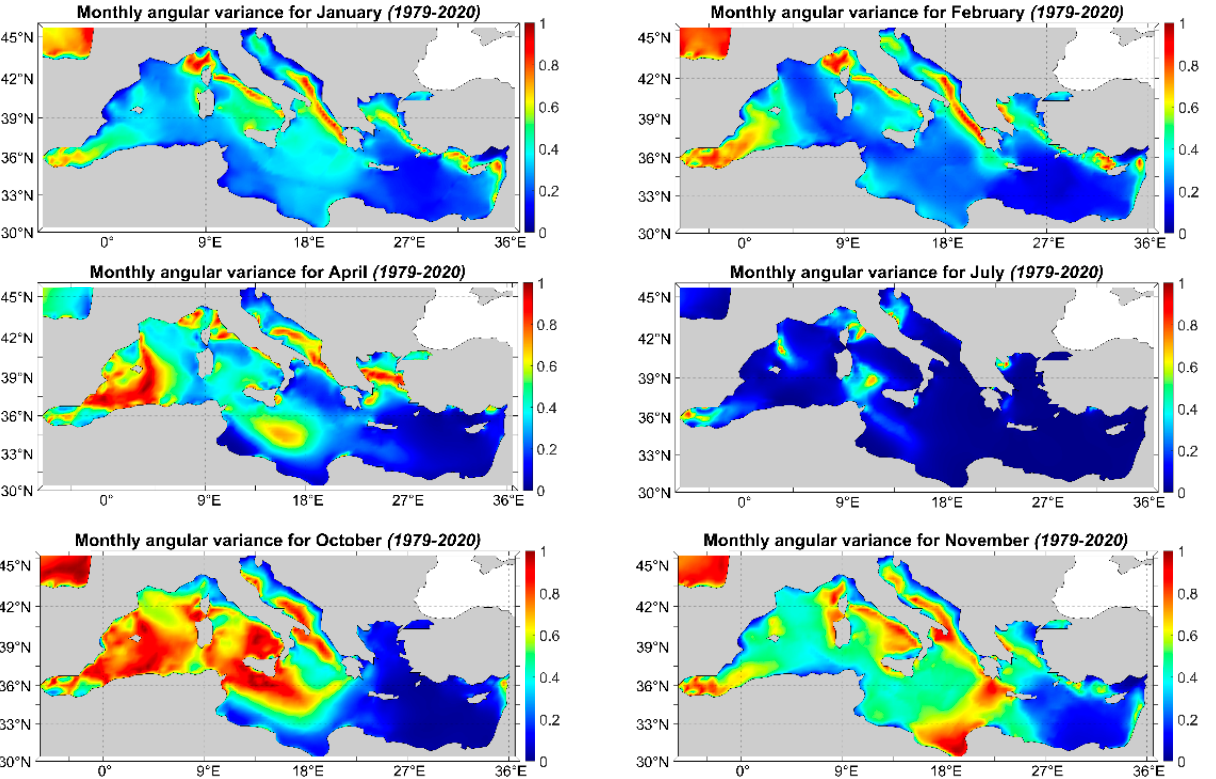
Figure 14. Monthly mean angular variance.